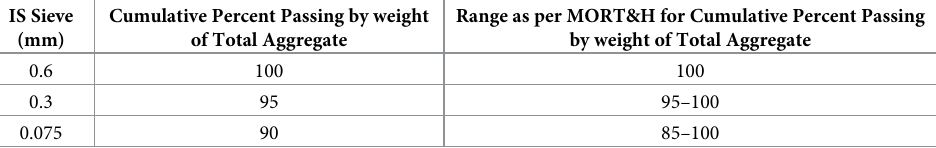
Table 2. Gradation of